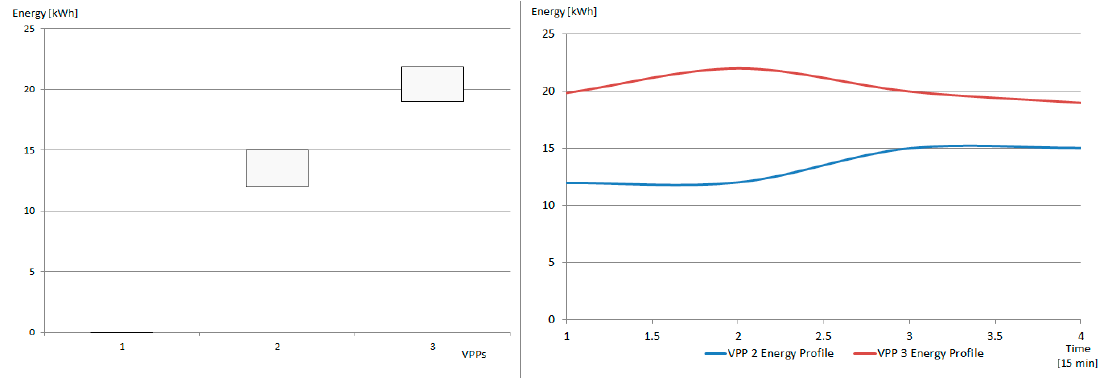
Figure 11. VPPs in the new created hierarchical VPP: [LEFT] maximum and minimum energy consumption in the service interval and [RIGHT] detailed energy profiles. Sensors 2019 , 12 , x; doi: FOR PEER REVIEW